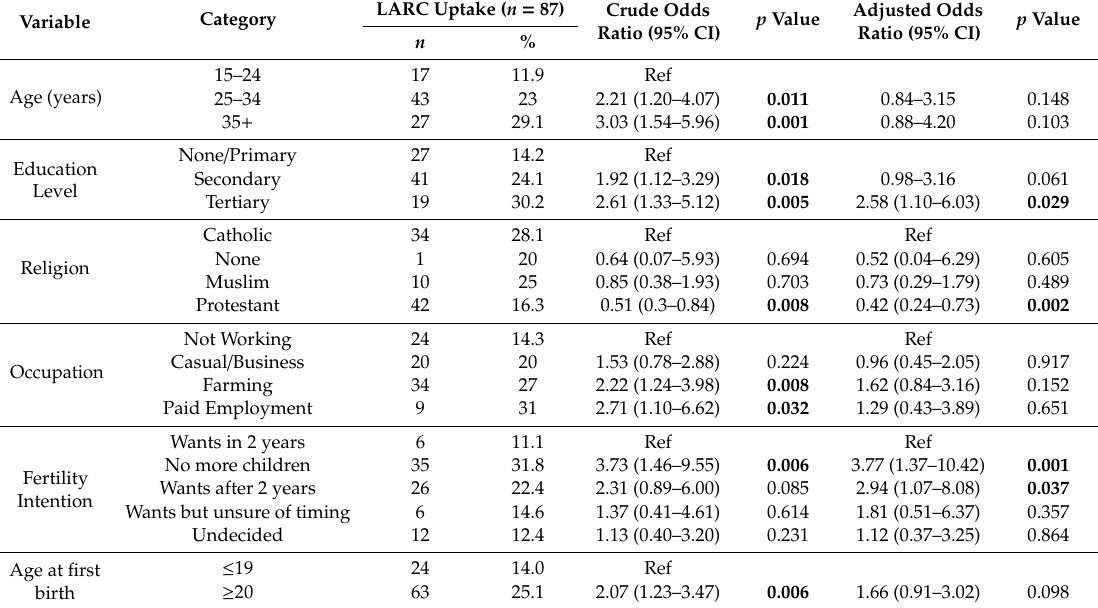
Table 2. Multivariable logistic regression of determinants of LARC uptake among women of reproductive